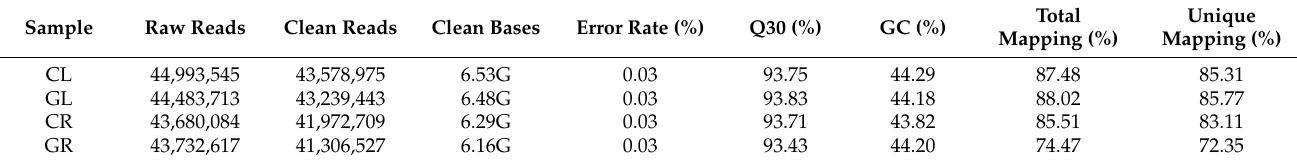
Table 1. Statistics analysis of sequencing data.